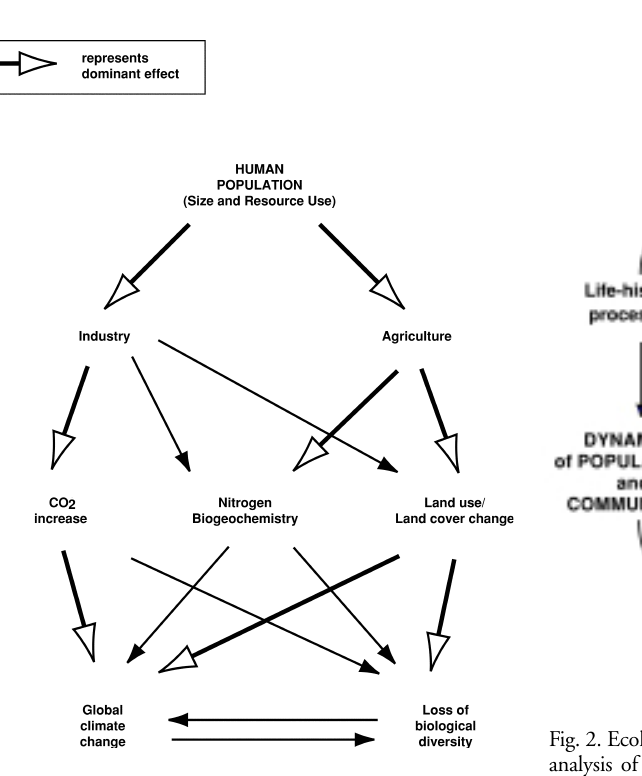
Fig. 1. The components of global environmental change empha- sized in this paper. The wide arrows represent dominant effects (from Vitousek 1994).